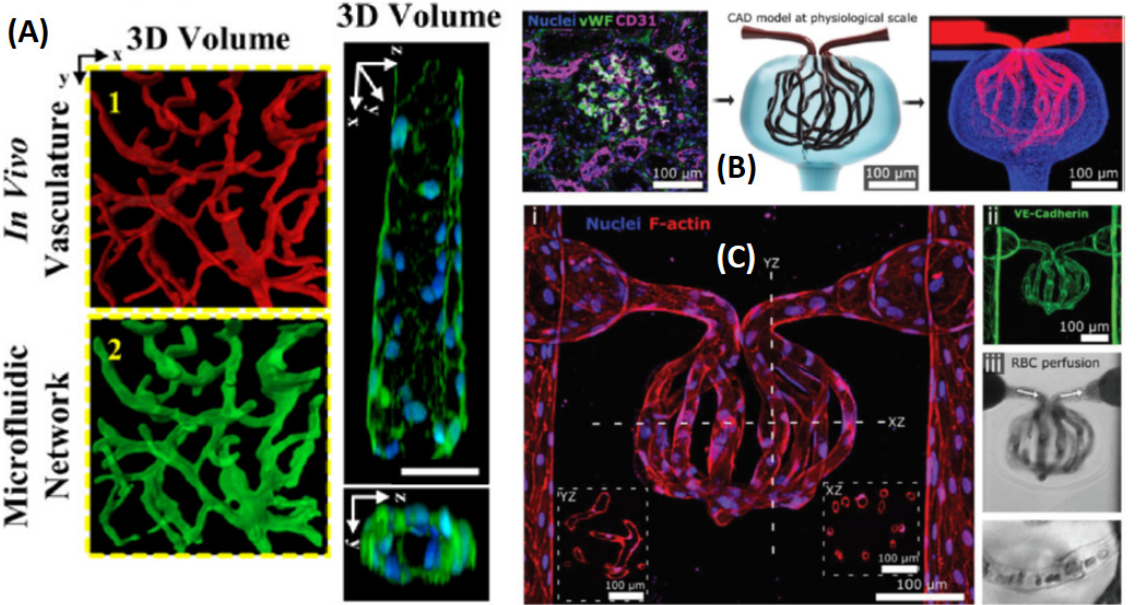
Figure 9. ( A) , Left: a microfluidic network is fabricated following the in vivo visualization of a mouse cerebral vessel bed to demonstrate the ability to recapitulate the dense, tortuous in vivo vascular network in PEGDA. Right: microchannels seeded with mouse brain endothelial cells, fluorescently labeled with DAPI (blue: nucleus) and ZO-1 (zona occludens protein-1; green: tight junctions), and imaged via confocal microscopy. Bar = 50 µm. ( B ): A human glomerulus (left) informed creation of a CAD photomask (middle) for collagen ablation. Image (right) shows ablated structure following bead perfusion of capillaries (red) and Bowman’s space (blue). ( C ): cellularized glomerular structure. (i) 3D projection of glomerulus with inset cross-sectional views through the YZ and XZ plane, respectively; (ii) VE-cadherin staining; (iii) RBC perfusion, with magnified view showing single-cell transit (bottom). Panel A adapted and reprinted with permission from [69]; ( B , C ) reprinted from [123].